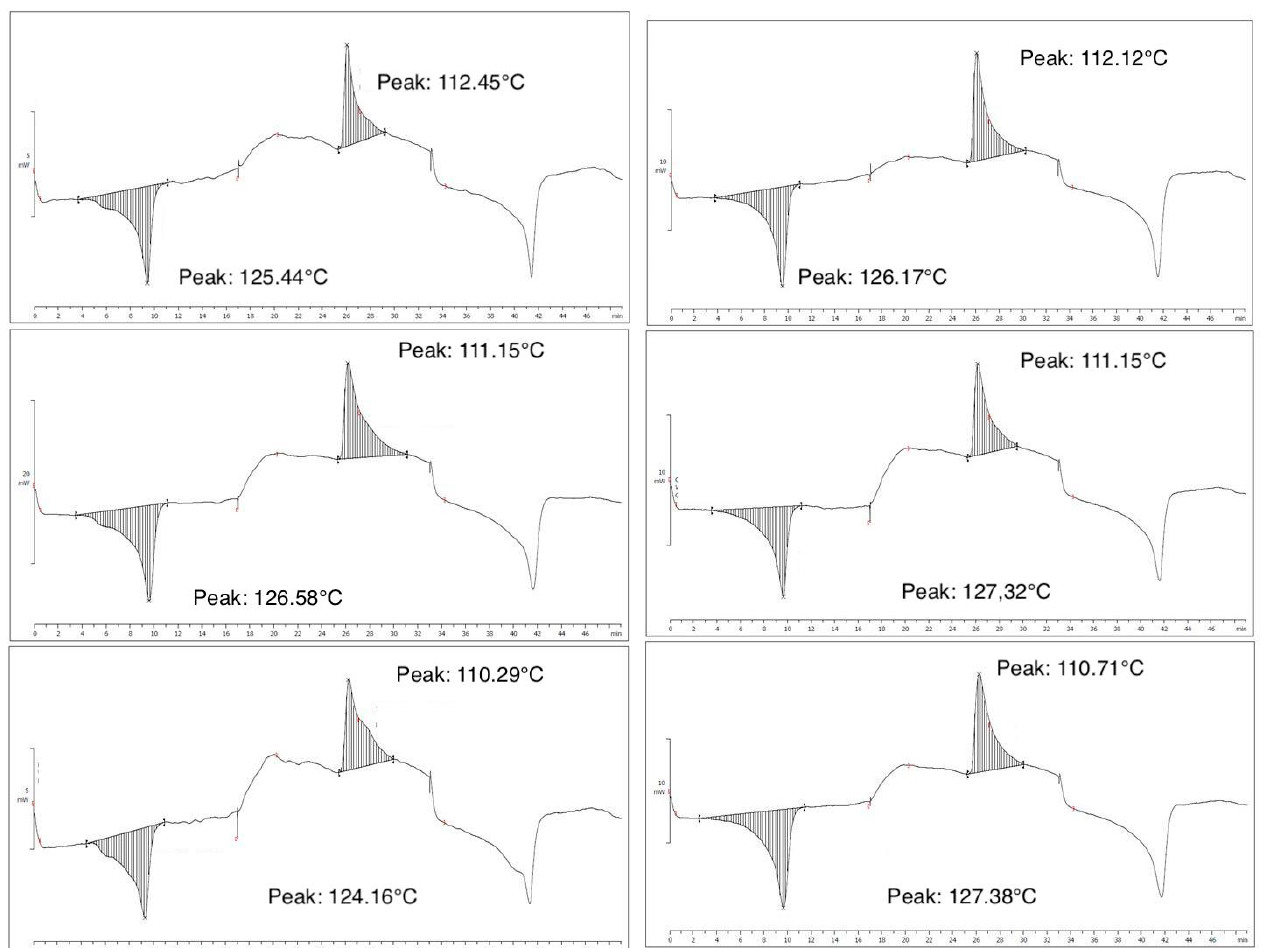
Figure 8. The DSC curves of all the scaled-up samples . Table 6. Melting temperature, crystallization temperature, and crystallinity of each sample accord- ing to the differential calorific scanning (DSC)